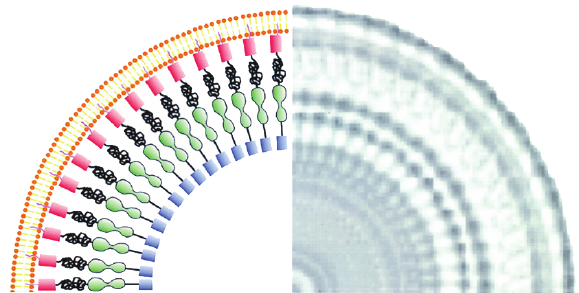
Figure 1: Structure of an immature MLV particle. A segment from a rotationally averaged cryoelectron microscopic image of a single immature MLV particle is shown on the right. As indicated on the left, the particle is bounded by a lipid bilayer (“LB”), and the MA domain of Gag (pink) is associated with the inner leaflet of the bilayer. Interior to the MA domain is a zone of low density, presumably corresponding to the p12 domain. The most conspicuous feature of the image is the “railroad tracks”, representing the two domains within the CA domain (green), followed by the NC domain (blue) with bound RNA. The Pol and Env proteins are not visible in this image. As the particle is ∼ 100 nm in diameter and the Gag molecules are ∼ 20nm in length, there is a region ∼ 60 nm in diameter largely occupied by solvent in the center of the particle. (Reproduced from [9]. Copyright 1998, National Academy of Sciences, USA.)